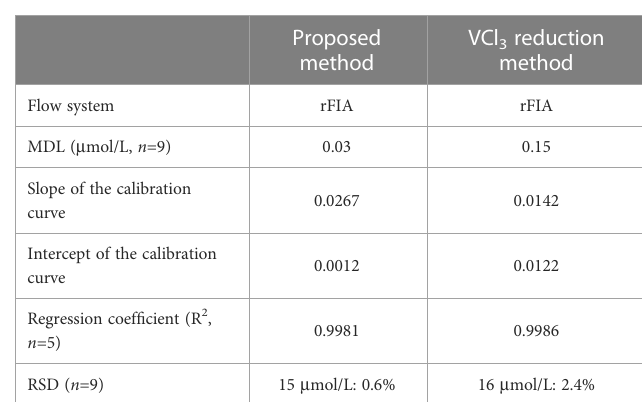
TABLE 1 Comparison of the analytical performance characteristics of the proposed method and the VCl 3 reduction method.